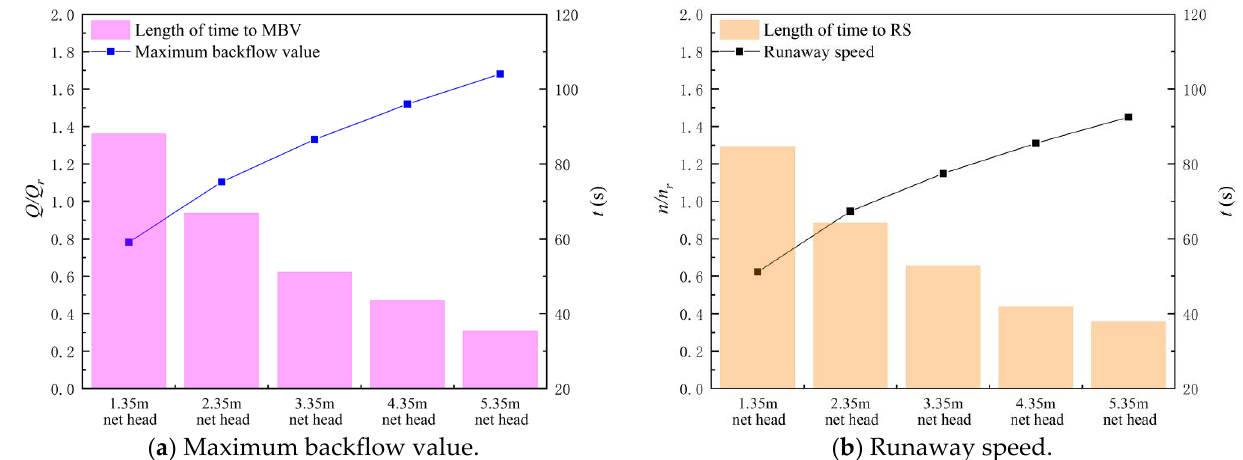
Figure 11. MBV and RS of the LAPS after a power failure in the case of the GOOC.